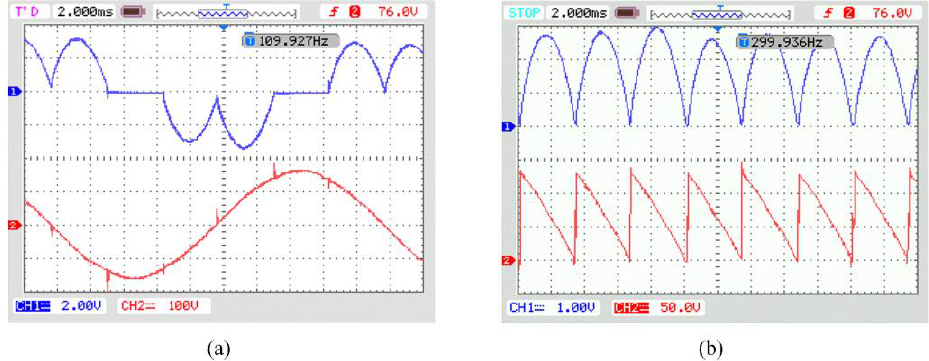
Figure 10. Exemplary results; the firing angle equal to 60°; motor idling speed; ( a ) input current and input line-to-line voltage waveforms; ( b ) motor current and motor supply voltage waveforms.